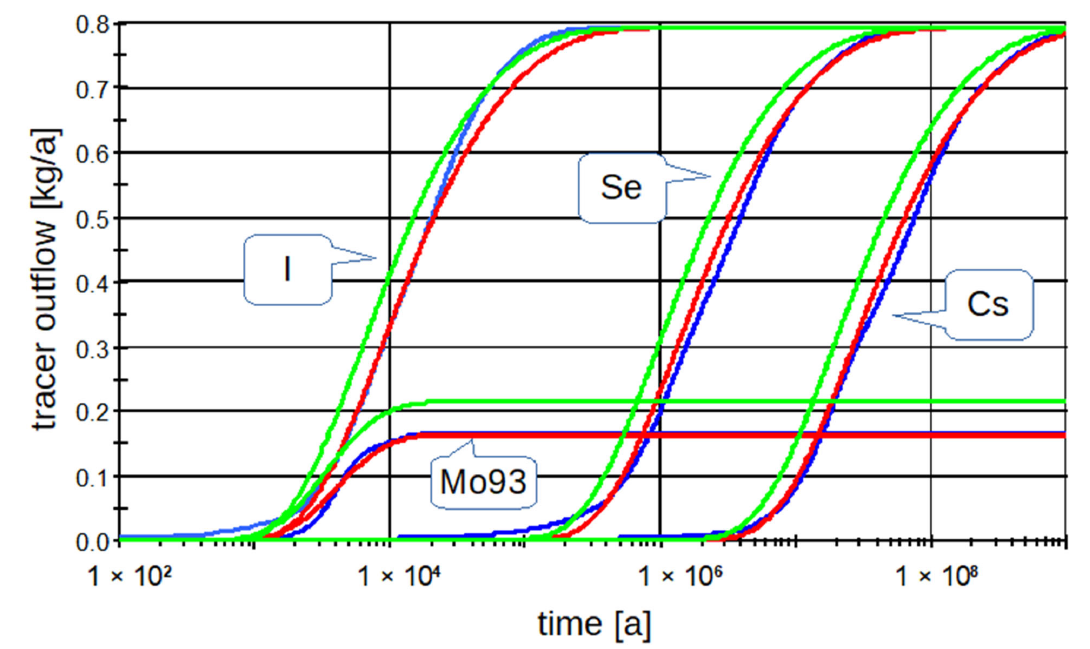
Figure 6. Comparison of tracer fluxes at site l1 from the Flow123d model (blue curves), from one “Pipe” component set from the postprocessing data (green curves), and the optimized “Pipe” component (red curves).